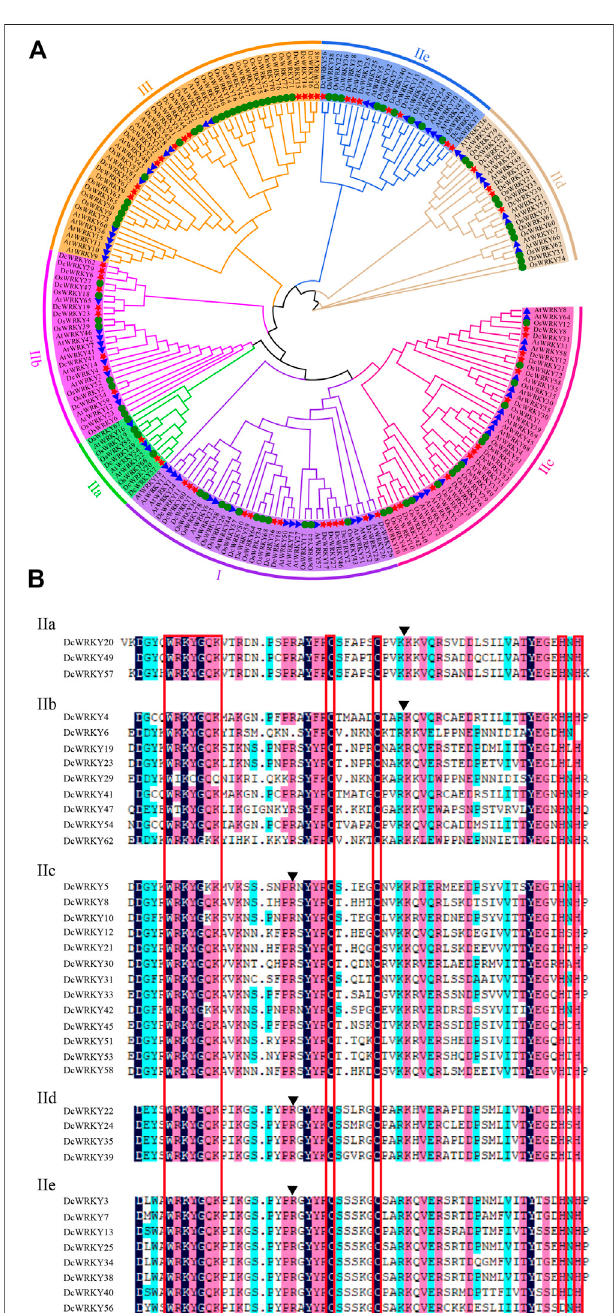
FIGURE 1 | Comparison of the WRKY family in plants. (A) Phylogenetic analyses of WRKY proteins from D. catenatum , Arabidopsis , and rice. A phylogenetic tree of WRKY proteins was constructed using MEGA-X with default parameters. The subgroups are indicated with different colors. The red stars represent D. catenatum WRKYs (DcWRKYs), the blue triangles represent Arabidopsis thaliana WRKYs (AtWRKYs), and the green circles represent Oryzasativa WRKYs(OsWRKYs). (B) Multiplesequencealignments of the WRKY domains from the group II DcWRKY members. Alignment was performed using DNAMAN. The red box indicates the conserved WRKY aminoacidsequenceandzinc- fi ngerdomain.Foreachsubgroup,theposition of a conserved intron is indicated by an